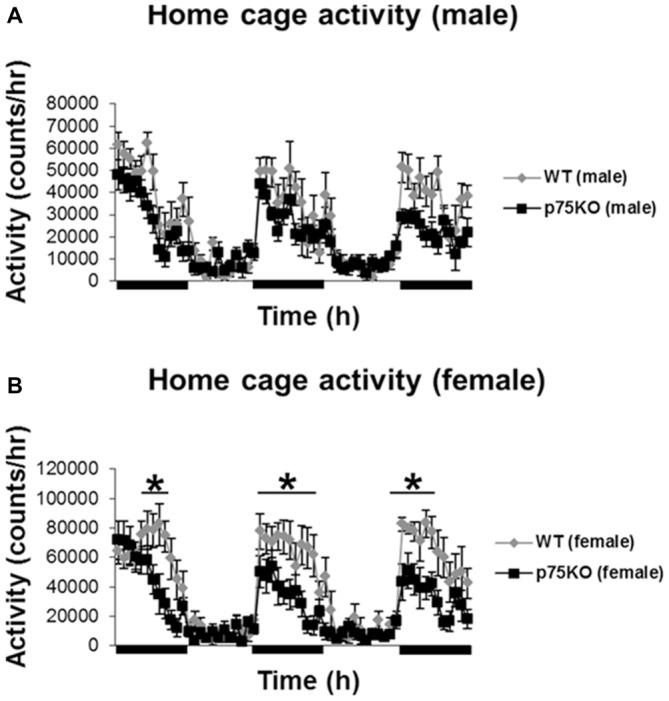
Altered activity during active nocturnal phase in the home cage test in female p75NTRexon IV−/− mice (B). Black bars indicate nocturnal/dark periods. Results of male mice are depicted in (A). wildtype (WT), gray bar; p75 neurotrophin receptor knockout (p75KO), black bar. Data are presented as Mean ± SEM, *p < 0.05.